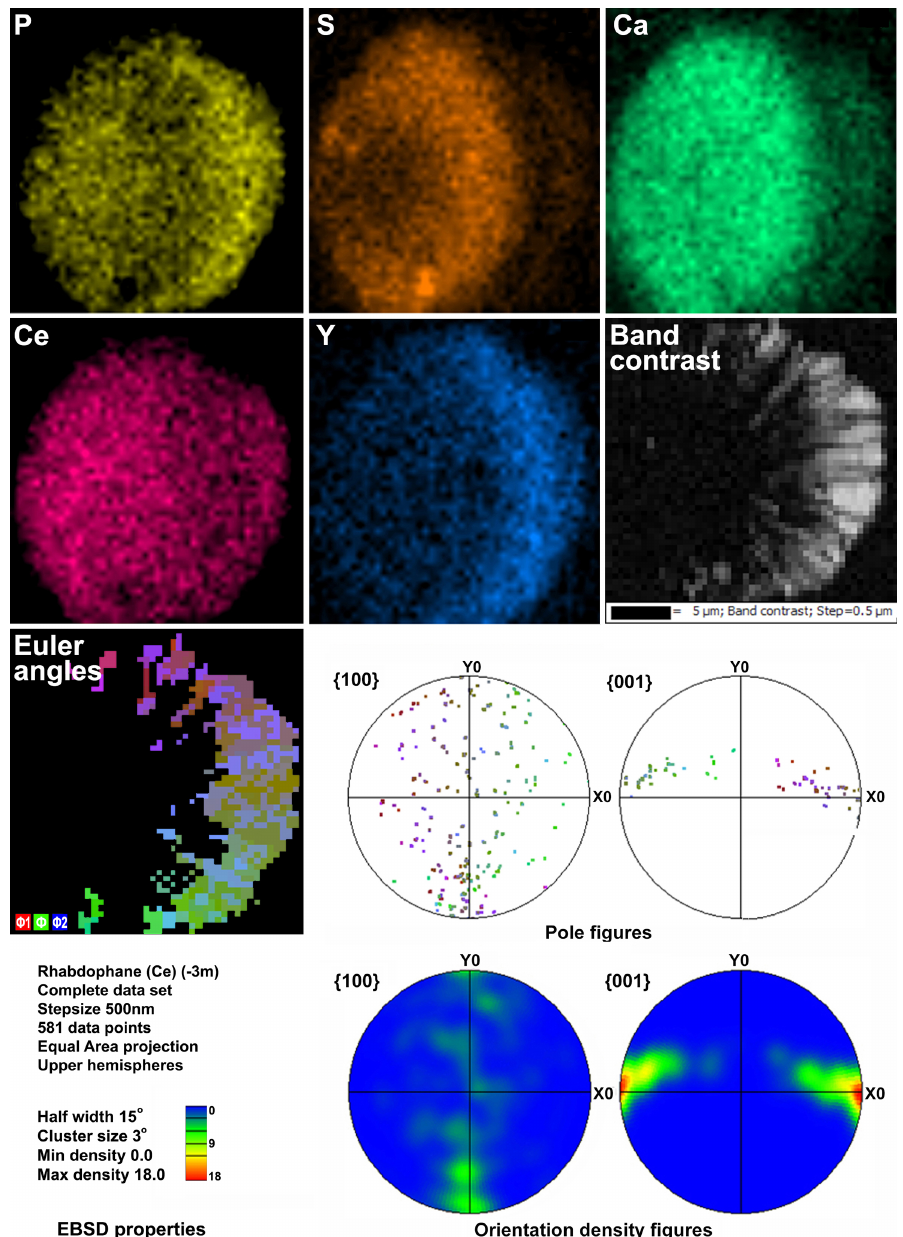
Figure 6. Distribution of elements, EBSD band contrast, rhabdophane crystal orientation in Euler colors, pole figures (each point in the pole figures corresponds to one point in the rhabdophane crystal orientation map and retains its color) and orientation distribution density heatmaps of spherical rhabdophane aggregate; for BSE image, see Fig.